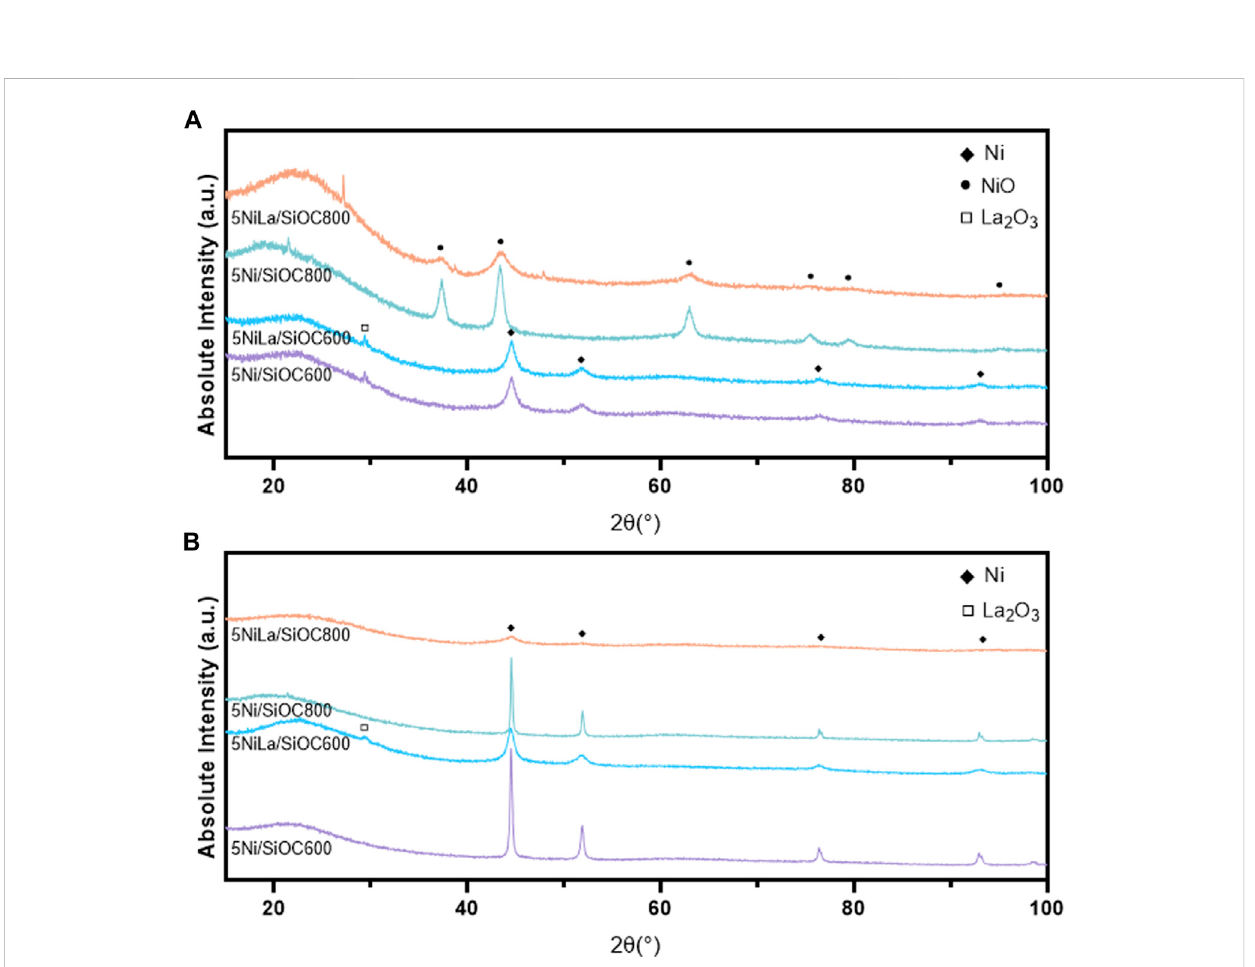
X-ray powder diffraction patterns of catalysts before (A) and after (B) catalytic test